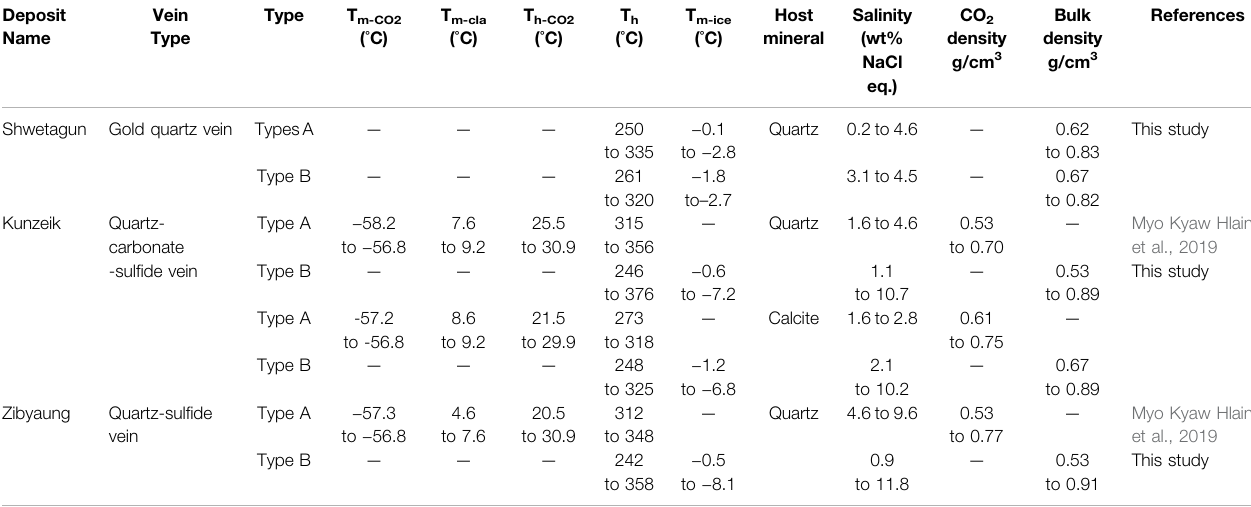
TABLE 2 | Comparative analyses of fl uid inclusion types and microthermometric results of the Shwetagun, Kunzeik and Zibyaung deposits.